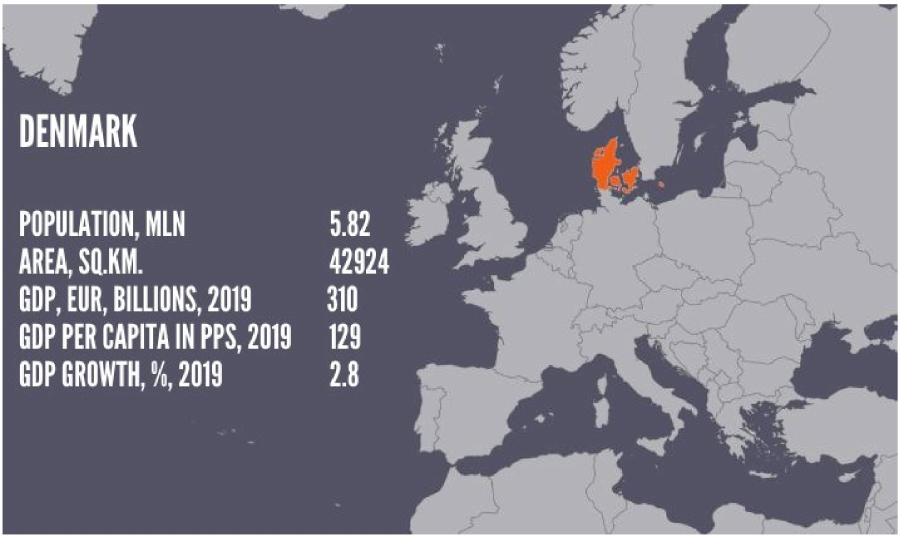
Figure 16. Stylized facts about Denmark (designed by the authors, based on